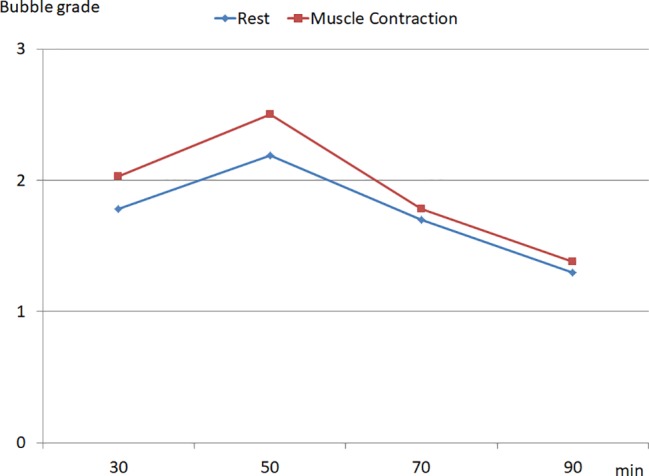
Time course of the bubble grade recorded after the dive, at rest and during muscle contraction of the lower limbs (data are expressed as median).